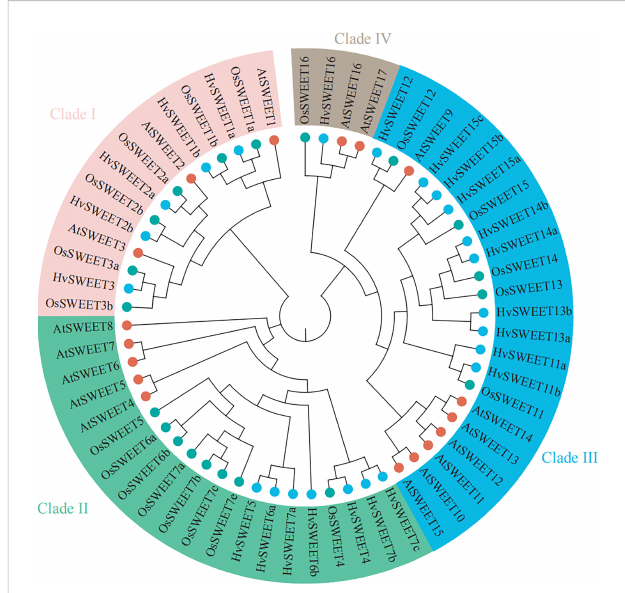
FIGURE 1 Phylogenetic relationship of SWEET family proteins of Arabidopsis, rice and barley. The phylogenetic tree is constructed using the neighbor-joining (NJ) method with 1000 bootstrap replications. Proteins of Arabidopsis, rice and barley are indicated with red, green and blue circles,